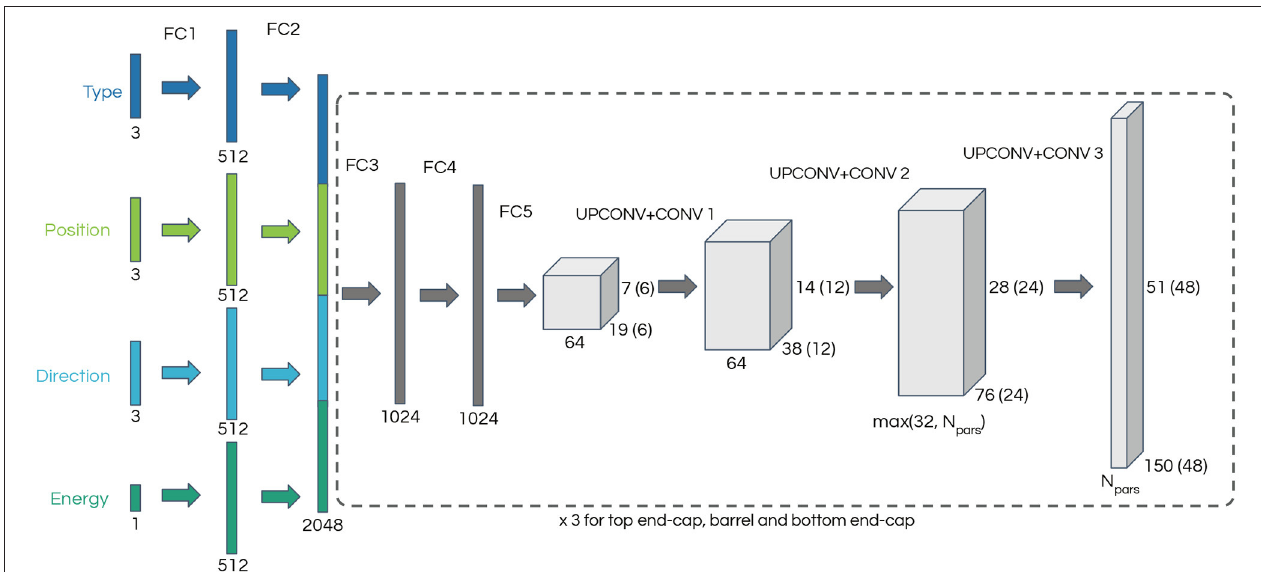
FIGURE 1 | Generative neural network architecture diagram. The input describes a single-particle state and consists of a one-hot vector encoding the particle type, two three-dimensional vectors corresponding to the particle starting position and direction cosines, and the particle energy. The section of the network enclosed in a dashed line is repeated three times, one for each region of the detector: two end-caps and one cylindrical barrel. The dimensions in brackets correspond to the end-caps. The number of output channels, N pars , depends on the parameterization of the loss